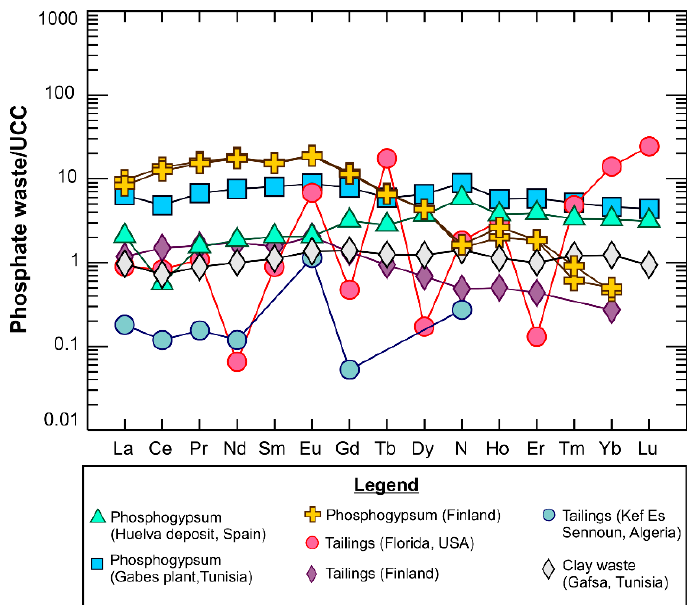
Figure 6. Upper continental crust (UCC) and normalised REE patterns of phosphatic mining wastes